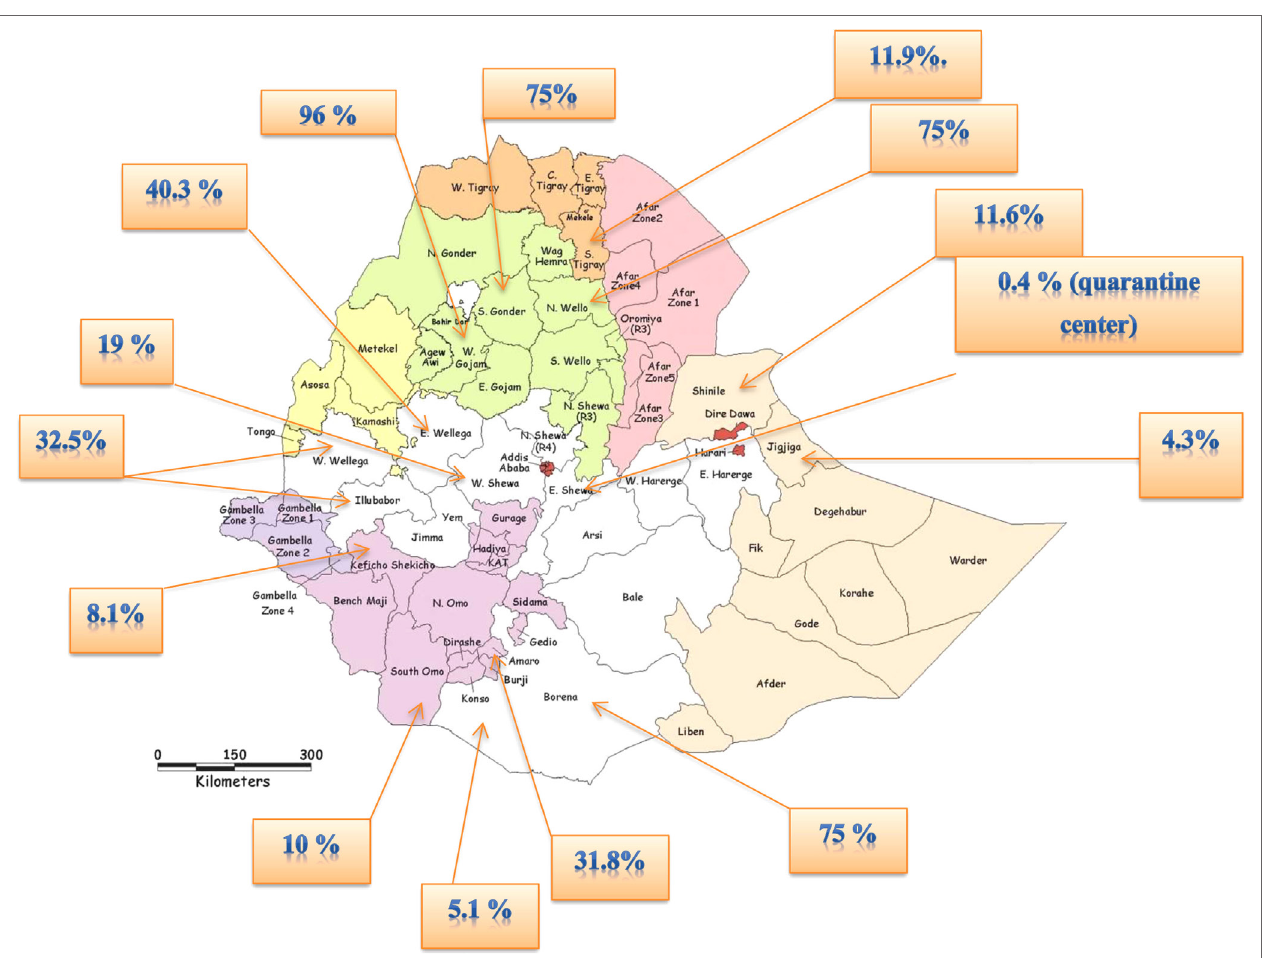
FiGURe 1 | The current distribution of contagious bovine pleuropneumonia in different areas of